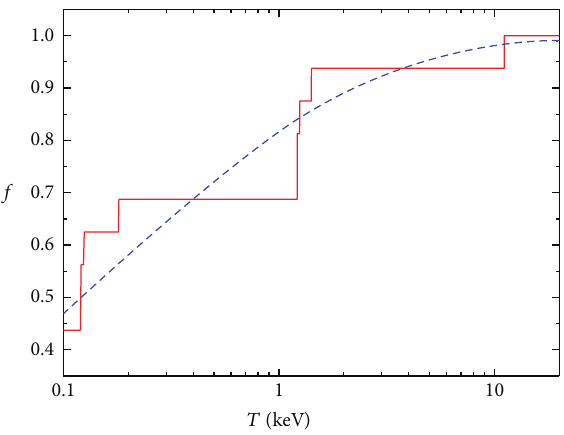
Figure 5: The atomic factor 𝑓 for germanium in the stepping approximation with the actual energies of the orbitals (solid line) and its interpolation in the Thomas-Fermi model (dashed line)